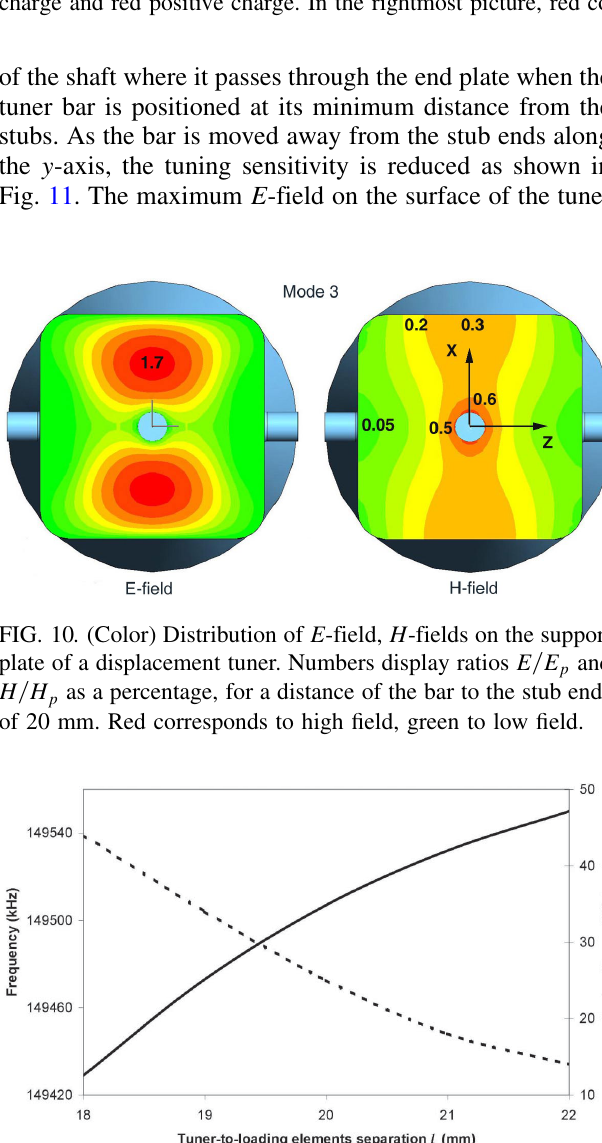
FIG. 9. (Color) Distribution of E -field, H -fields at a displacement bar tuner in a 3-QWR for the accelerating mode. The perspective of the figures makes the center stub appear to be closer to the tuner than the outer ones. In the center picture, E=E charge and red positive charge. In the rightmost picture, red corresponds to high H -field, green to low field.